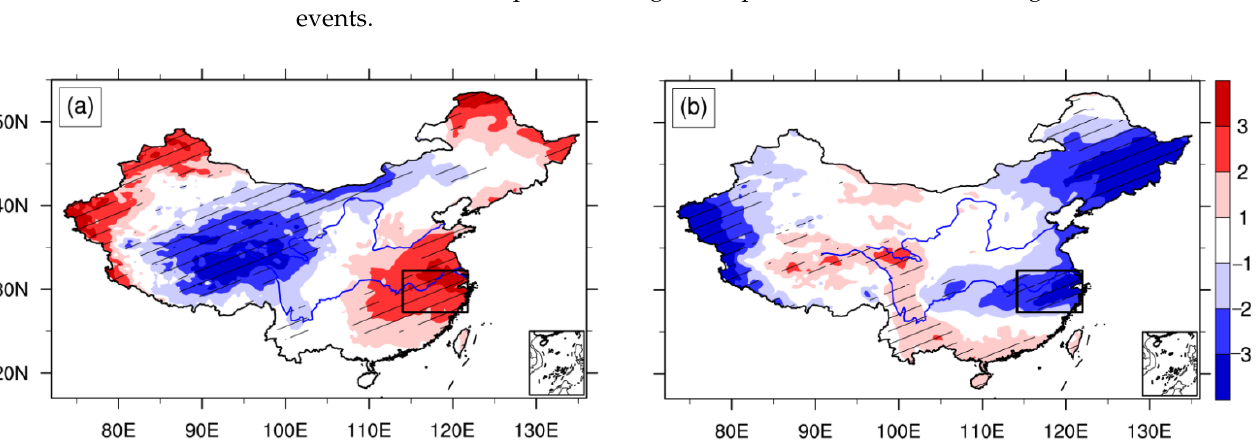
Figure 7. Spatial distribution of the average temperature anomalies (( a , b ); units: ◦ C) during the SRP+ ( a ) and SRP − ( b ) events; The slash shadings indicate that the anomalies are statistically significant at the 0.05 confidence level. Black rectangles in Figure 7a,b denote the YRV regions (114–122 ◦ E, 27–32 ◦ N) which are selected to calculate the domain-averaged temperature